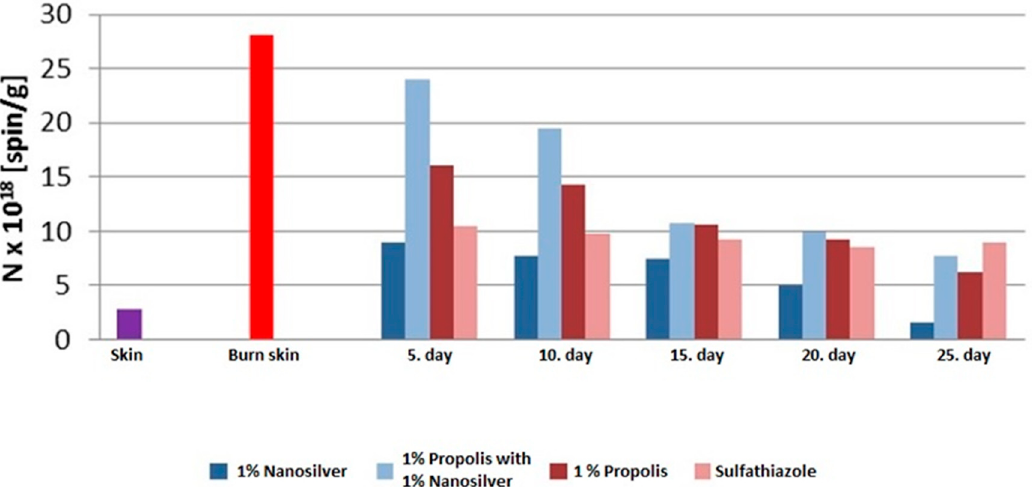
Figure 33. The effect of ointment therapy with 1% nanosilver (D2), 1% propolis and 1% nanosilver (D3), 1% propolis (D1), and sulfathiazole (K) on the concentration (N) of free radicals in burn wounds on days 5, 10, 15, 20, and 25 of the therapy and in healthy skin.